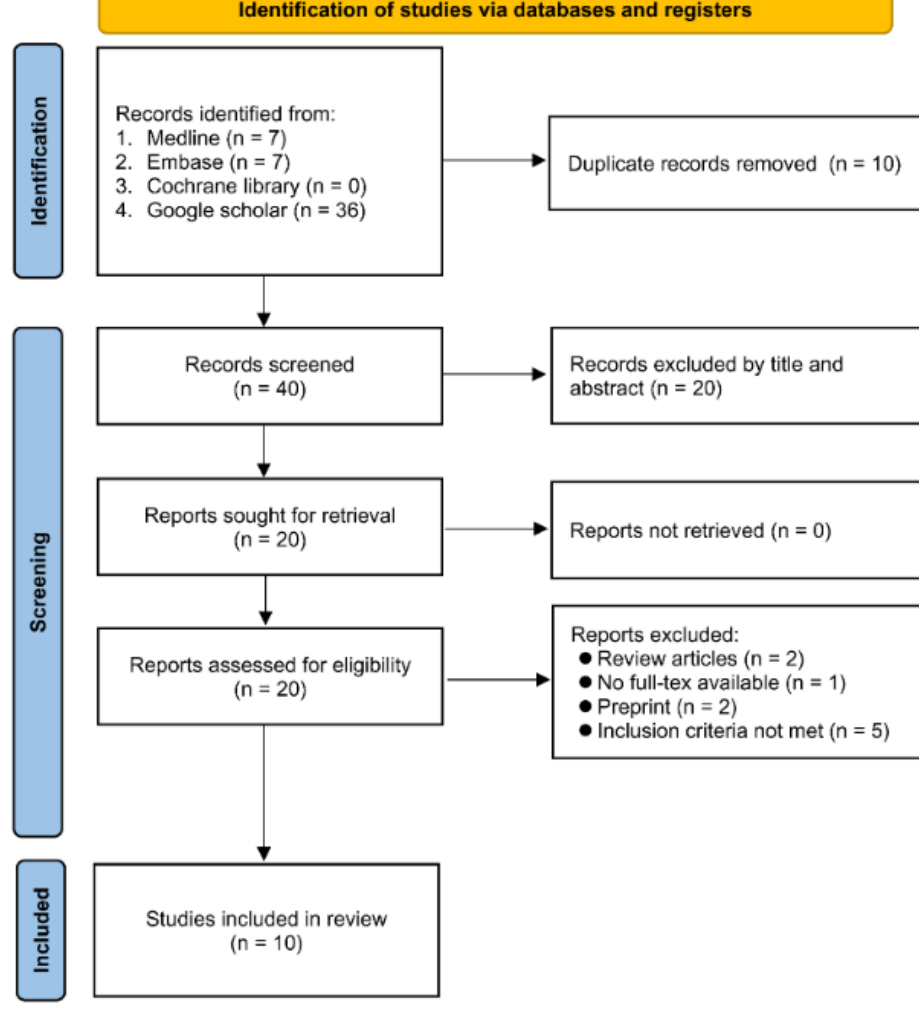
Figure 1. Flow chart for inclusion and exclusion.